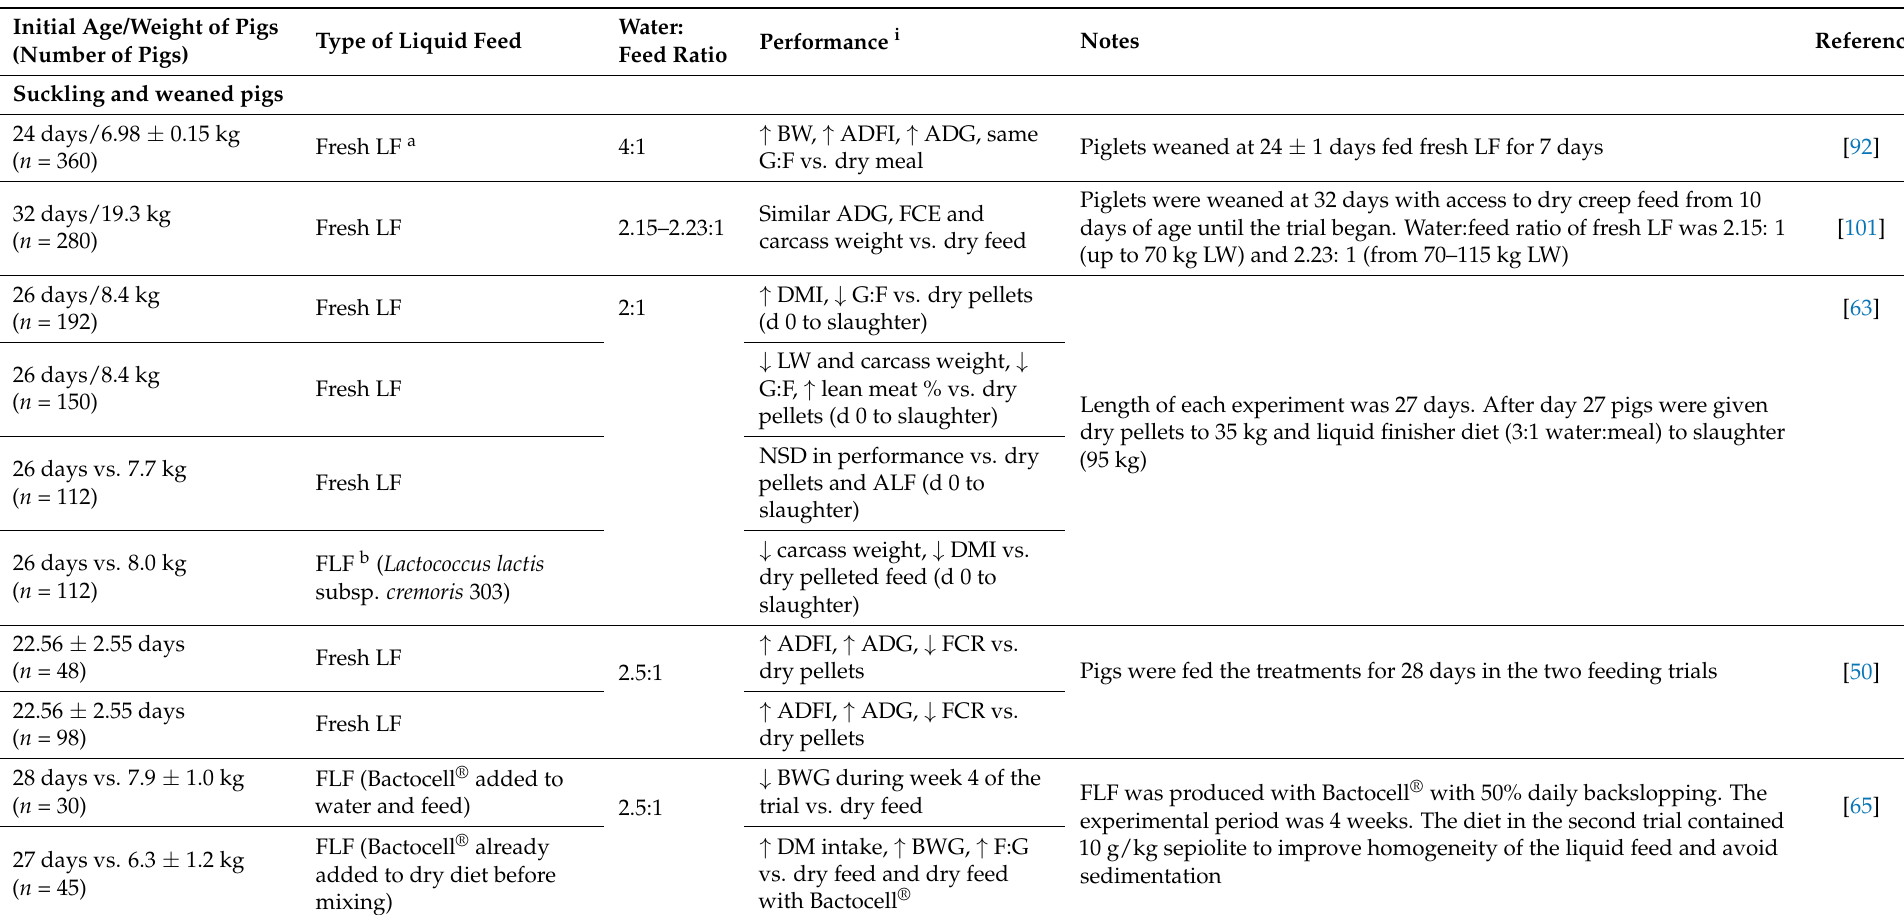
Table 9. Growth performance, feed intake, feed efficiency and carcass quality of suckling, weaned and grow-finishing pigs fed fresh, fermented, cereal fraction only fermented, soaked and enzyme-supplemented liquid